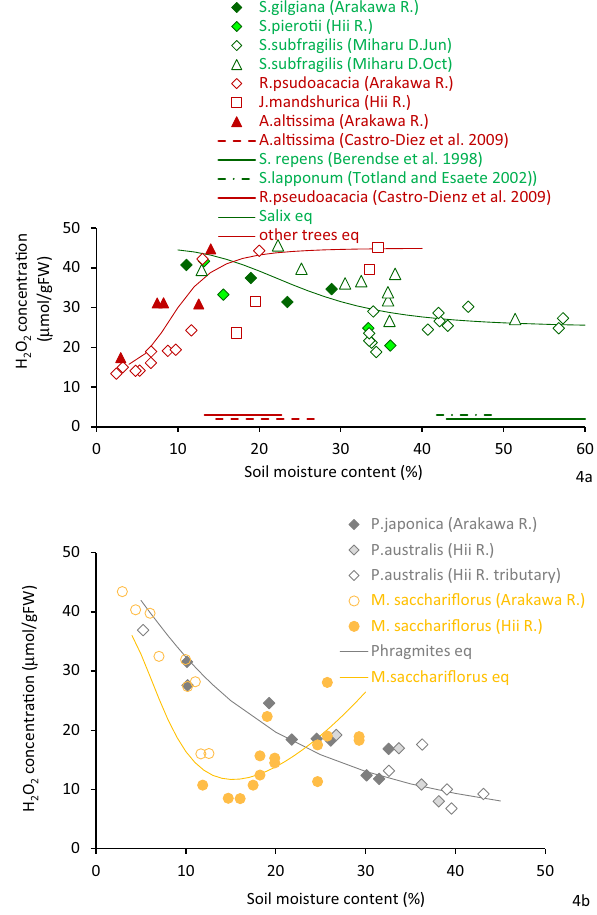
Figure 4. Relationship between soil moisture and leaf H 2 O 2 for ( a ) different tree species and ( b ) herbaceous species. Reported soil moisture contents are added (Castro-Diez et al. 55 ; Berendse et al. 56 ; Totland and Esaete 57 ).